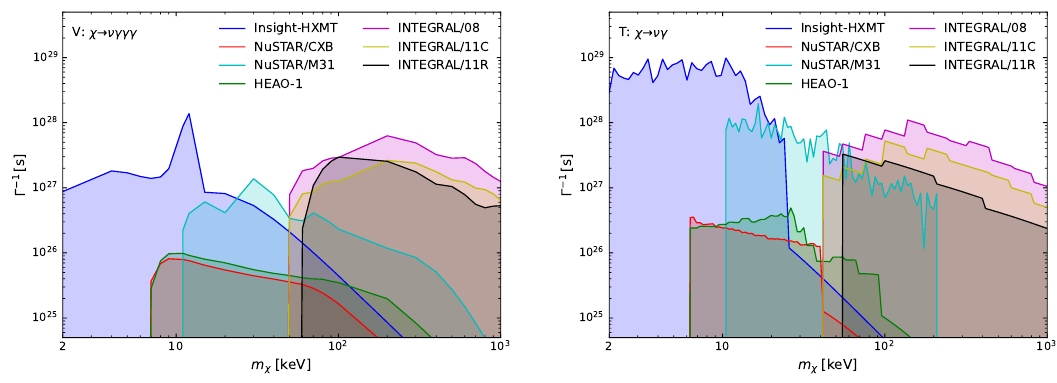
Figure 7 . The astrophysical X-ray and gamma-ray constraints on the visible decay width of χ → ν + γ ( s ) as a function of the DM mass m χ . For illustration, the vector operator with continuum spectrum from χ → νγγγ and the tensor one with discrete δ -function from χ → νγ are shown in the left and right panels,